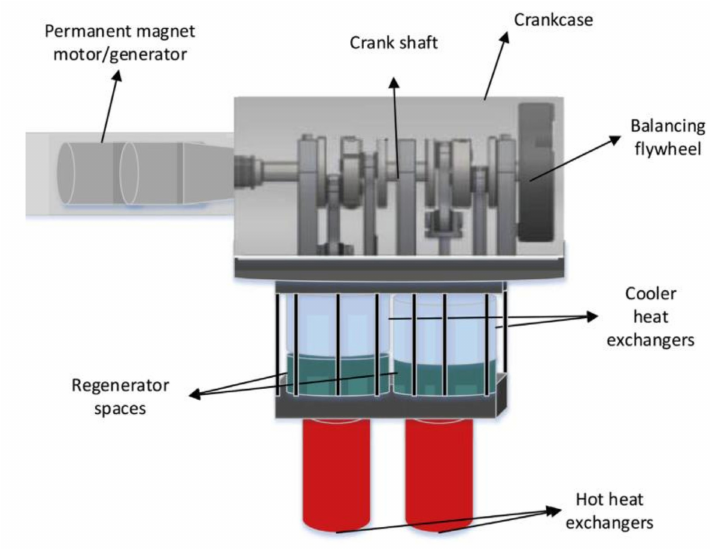
Figure 1. Genoa Stirling engine scheme [27,28].